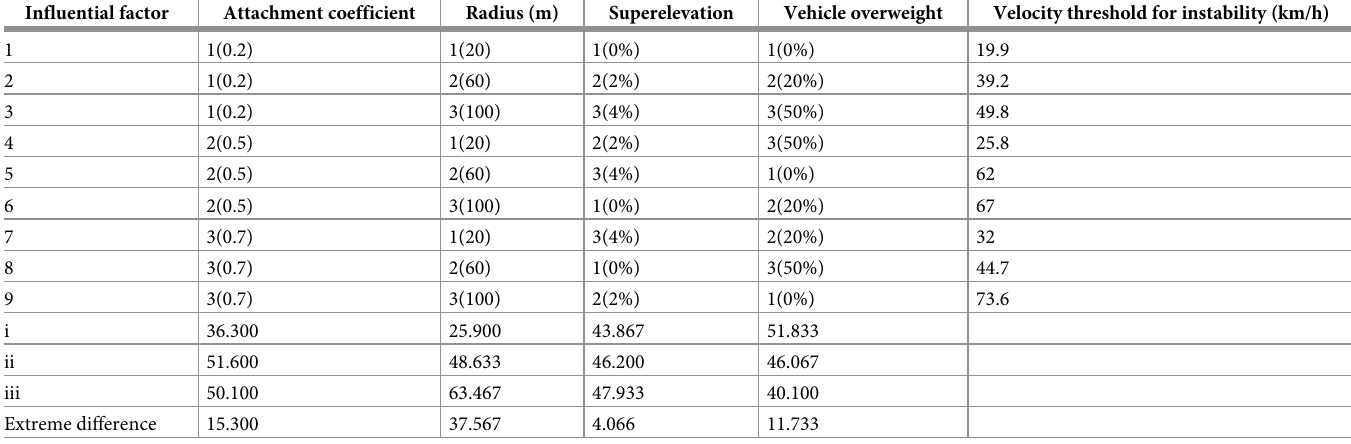
Table 2. Results of orthogonal experiment L 9 (3 4 ) on factors affecting speed threshold of vehicle instability. Influential